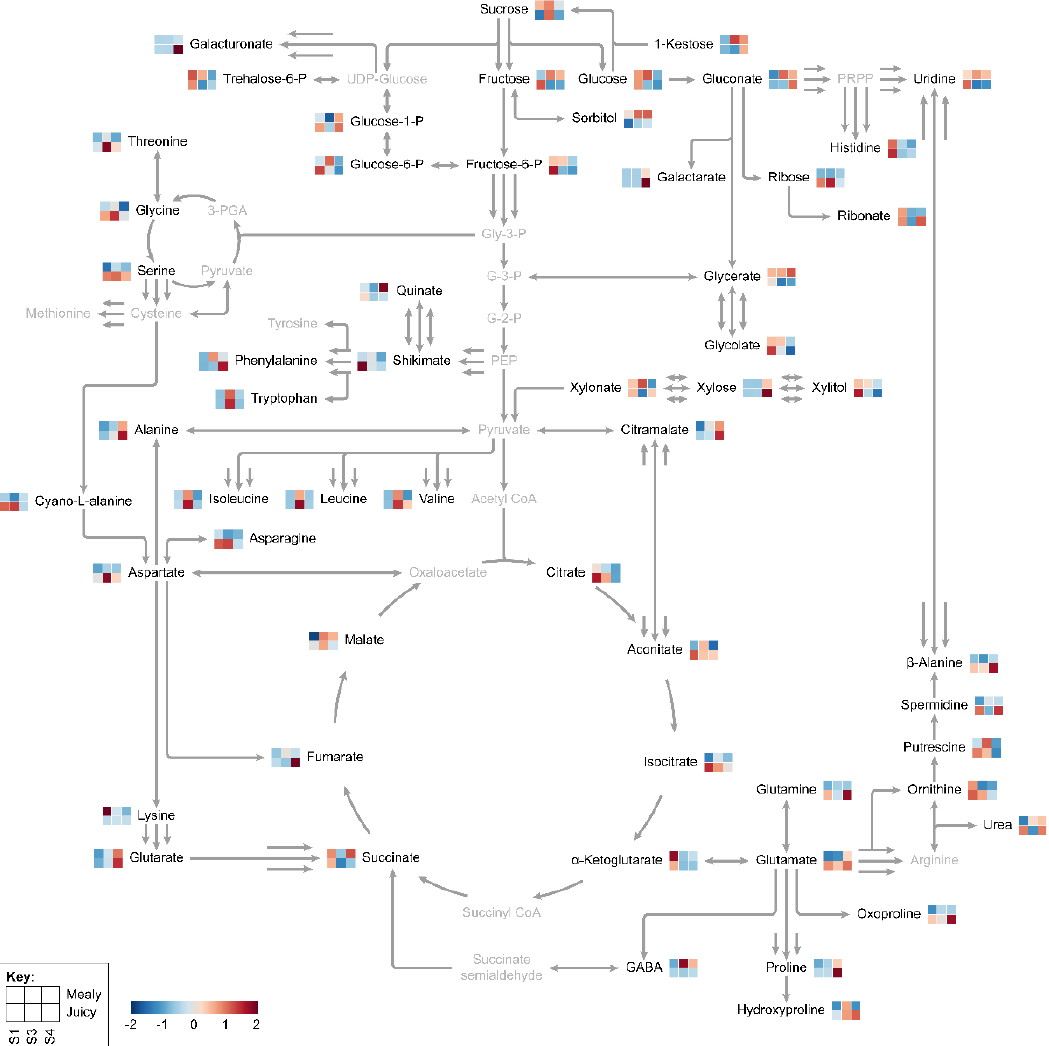
Figure 6. Primary metabolism pathway reconstruction. The map shows the metabolites identified with p < 0.05 in black letters, while metabolites not identified or with p > 0.05 in grey letters. Relative abundance of metabolites was averaged over three biological replicates ( n = 3).